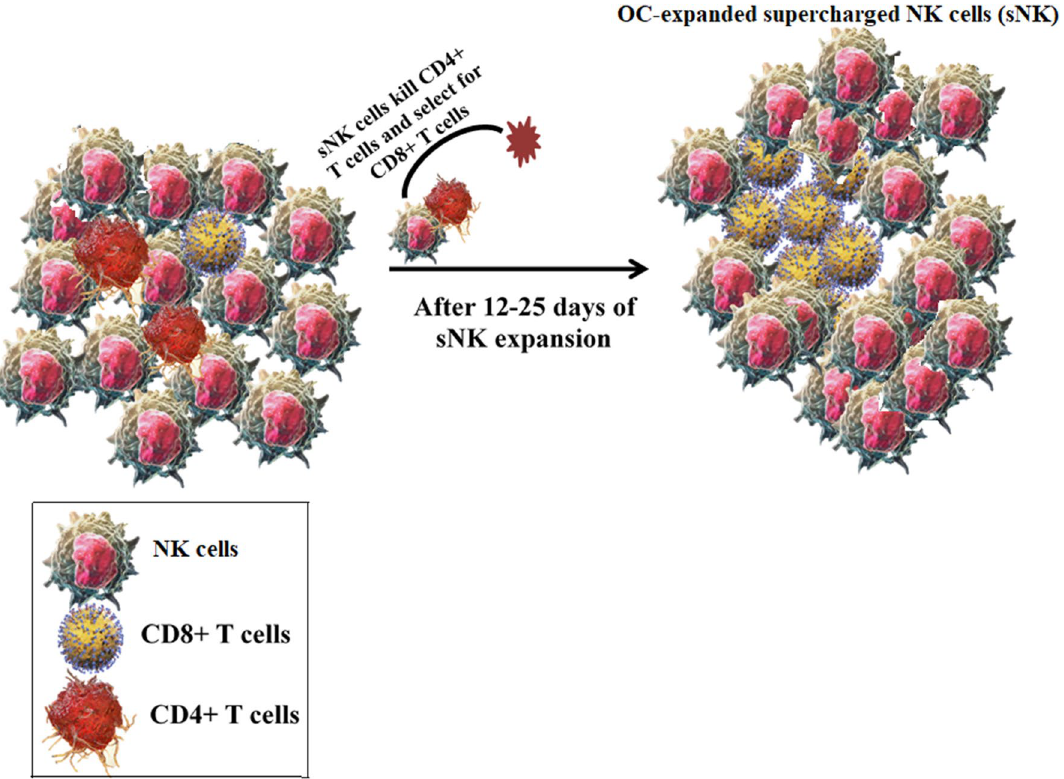
Figure 8. Schematic representation of mechanisms for the selection and expansion of CD8 + T cells by OC-expanded supercharged NK cells. Freshly purified NK cells with 1–3% contaminated T cells (CD4 + and CD8 + T cells) were treated and co-cultured with OCs as described in Materials and Methods (left panel). After days 12–25 of co-culture, the OC-expanded cells express approx. 20% T cells majority of which are CD8 + T cells (right panel). The expansion of CD8 + T cells is likely due to the lysis of CD4 + T cells by the super-charged NK